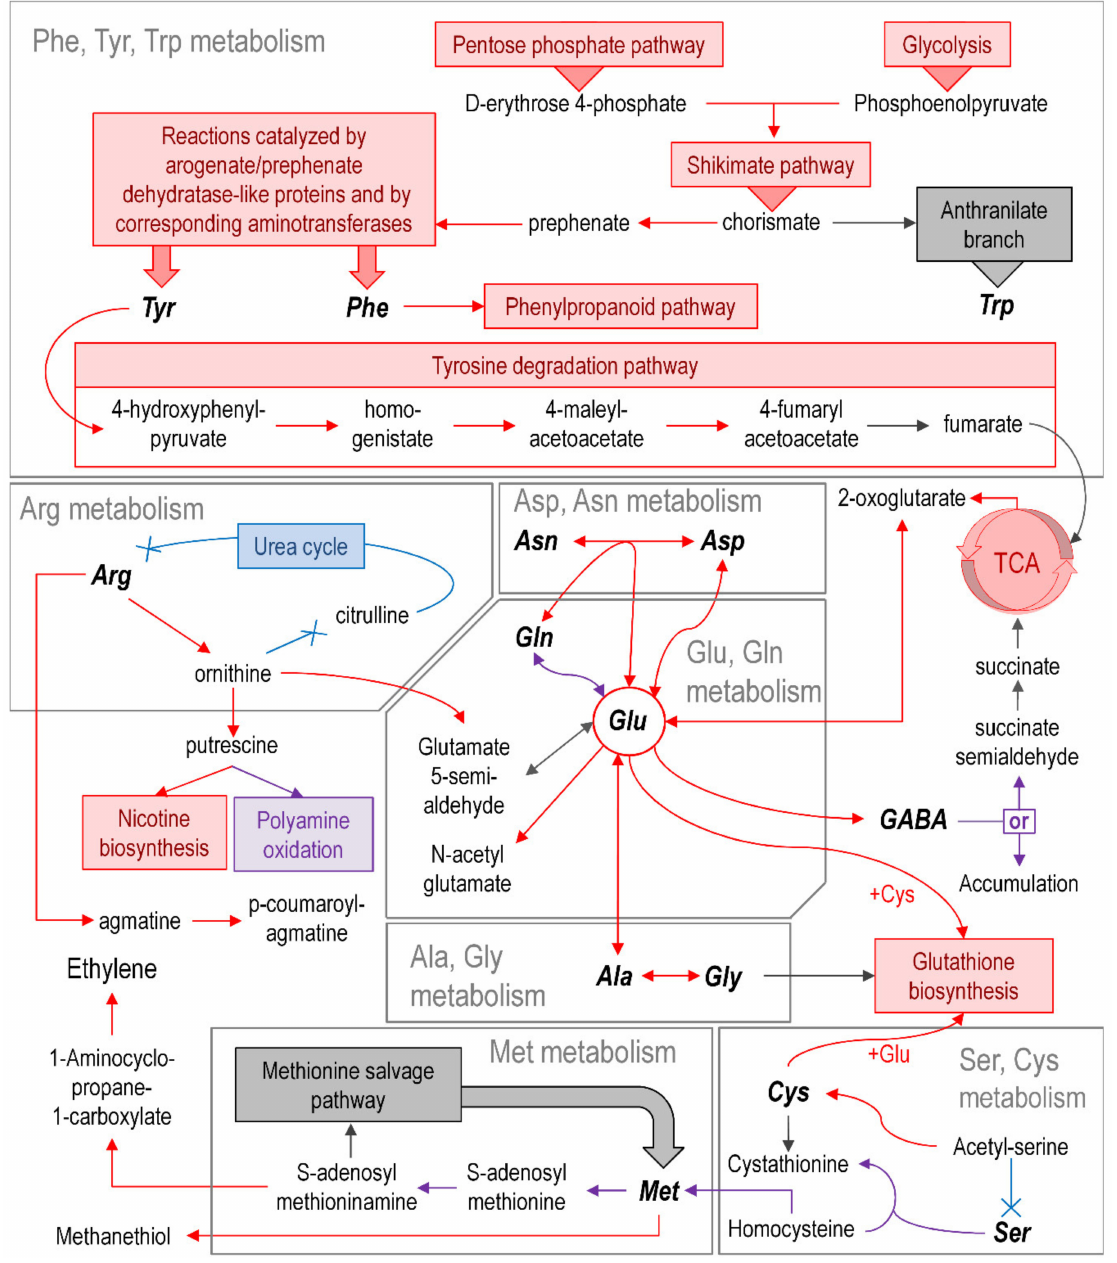
Figure 4. Regulation of genes related to amino acid metabolism in tobacco plants infected by P. atrosepticum . Reactions catalyzed by enzymes encoded by mostly upregulated, mostly downregulated, non-DEGs, andbothup-anddownregulatedDEGsaremarkedinred, blue, gray, andpurple, respectively. TCA, tricarboxylic acid cycle. The abbreviated names of amino acids are provided in accordance with the International Union of Pure and Applied Chemistry (IUPAC) recommendations. The scheme was assembled based mostly on Kyoto Encyclopedia of Genes and Genomes (KEGG) reference pathways as well as the SwissProt database and sources of literature cited in the